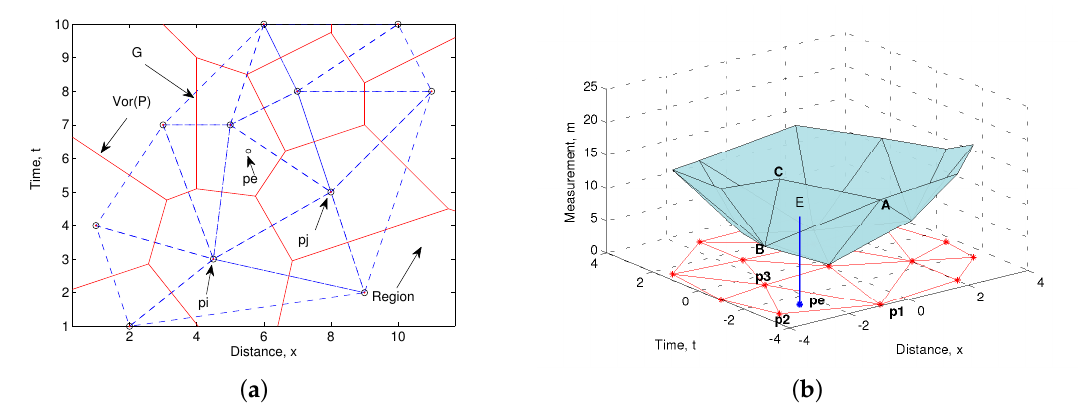
Figure 2. Representation and nomenclature of the elements in our Delaunay interpolation: ( a ) Delaunay triangulation and Voronoi diagram; and ( b ) obtaining a polyhedral from a set of sample